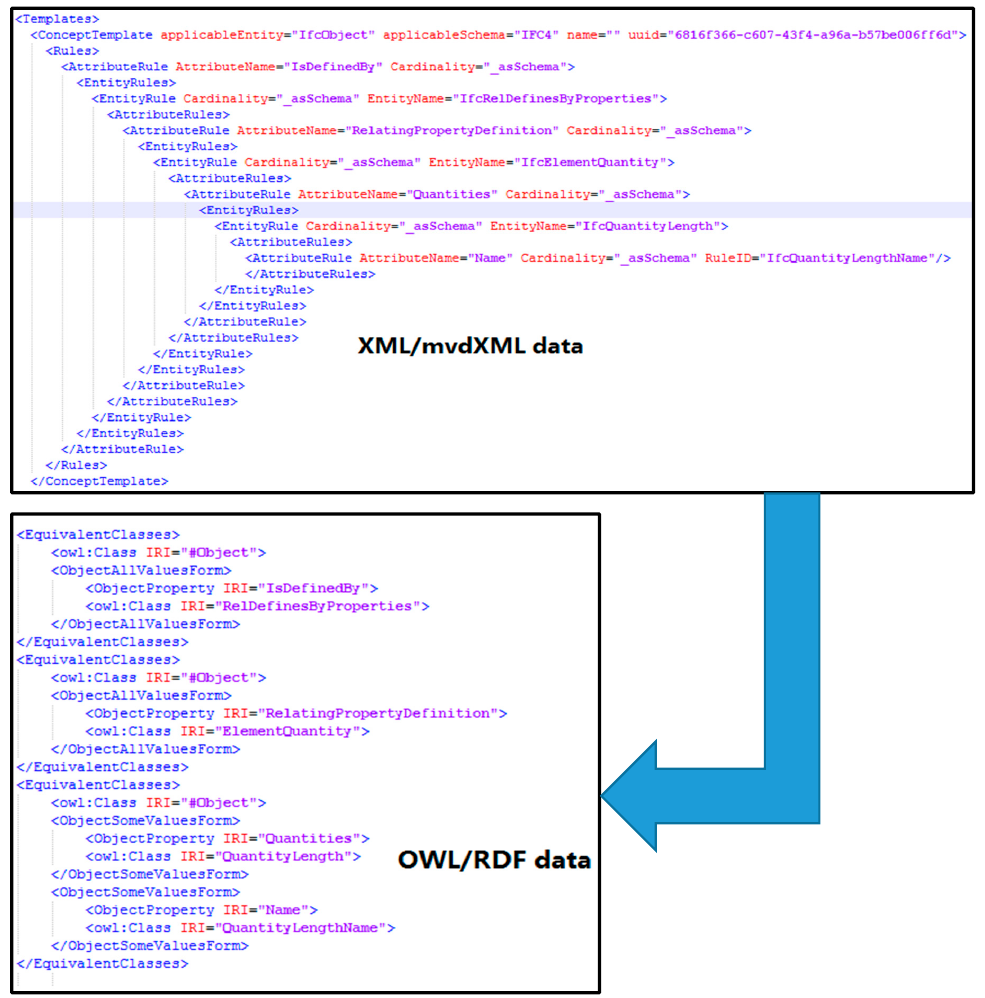
Figure 1. Transform between XML/mvdXML and OWL/RDF data.